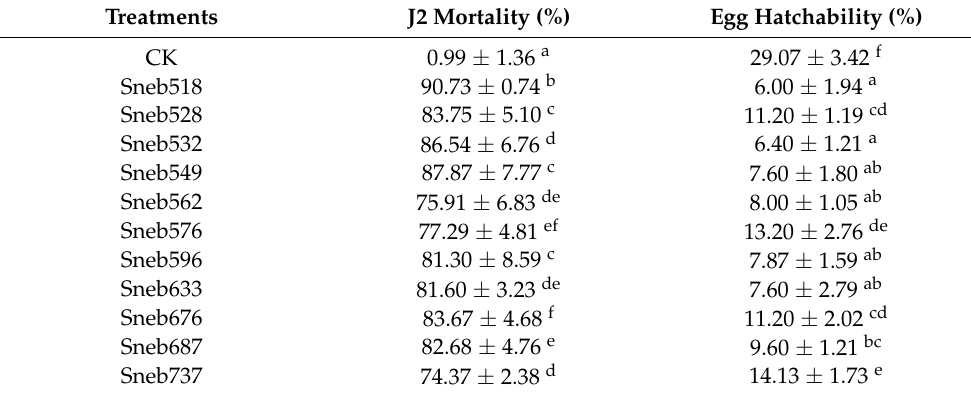
Table 1. Preliminary screening results of bacterial strains against M. incognita .